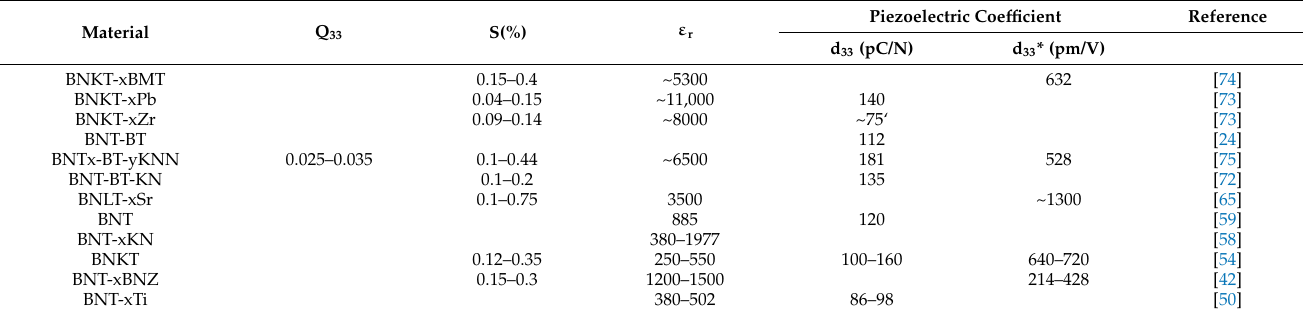
Table 3. Summary of piezoelectric properties of BNT